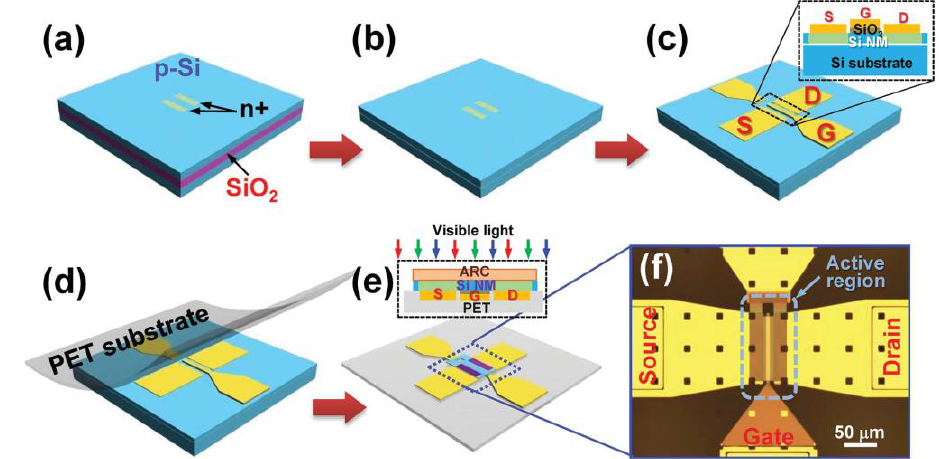
Figure 16. The schematic illustration of the device fabrication process flow. ( a ) Beginning with forming n+ regions by ion implantation of source/drain regions to achieve an ohmic contact. ( b ) Releasing Si NM by selective etching of a buried oxide layer. ( c ) Metallization by e-beam evaporation to deposit source/drain electrodes and a stack of gate/gate dielectric. ( d ) Transfer printing fully-fabricated devices to adhesive layer-coated PET substrate. ( e ) Spin-coating a protection layer on top of the surface. ( f ) Microscopic image of a finished flexible phototransistor. Insets in (c,e) depict the cross-sectional view of device (reprinted from [25]).